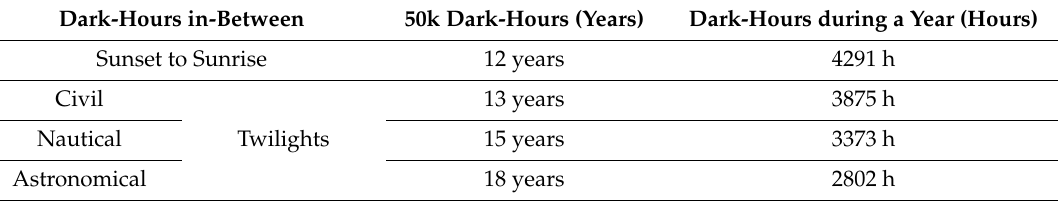
Table 2. Elapsed time till 50k hours of operation of a streetlighting luminaire in years, in Hungary. Dark-Hours in-Between 50k Dark-Hours (Years)